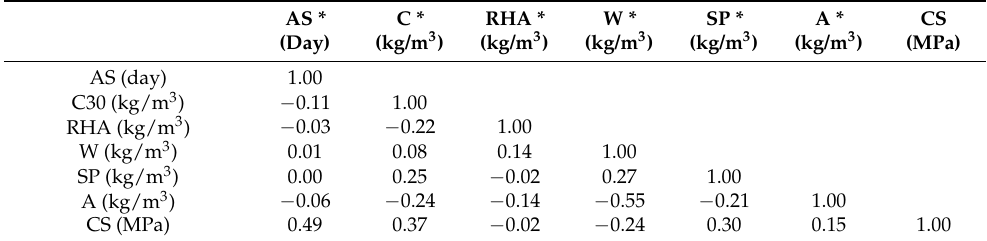
Table 1. Coefficient of correlation (R) for explanatory variables. AS *